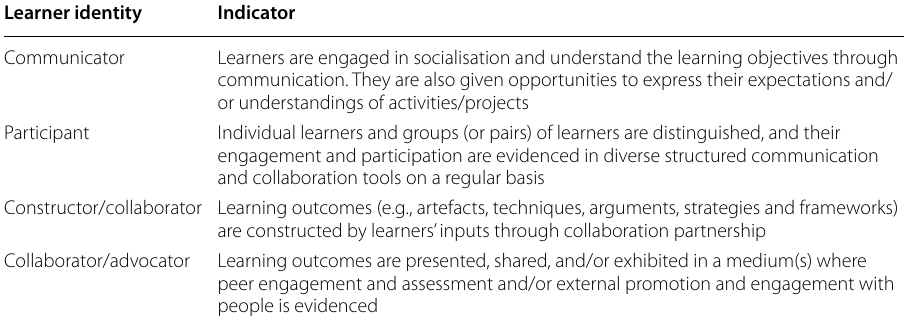
Table 3 Evaluation indicators of learner identity changes Learner identity